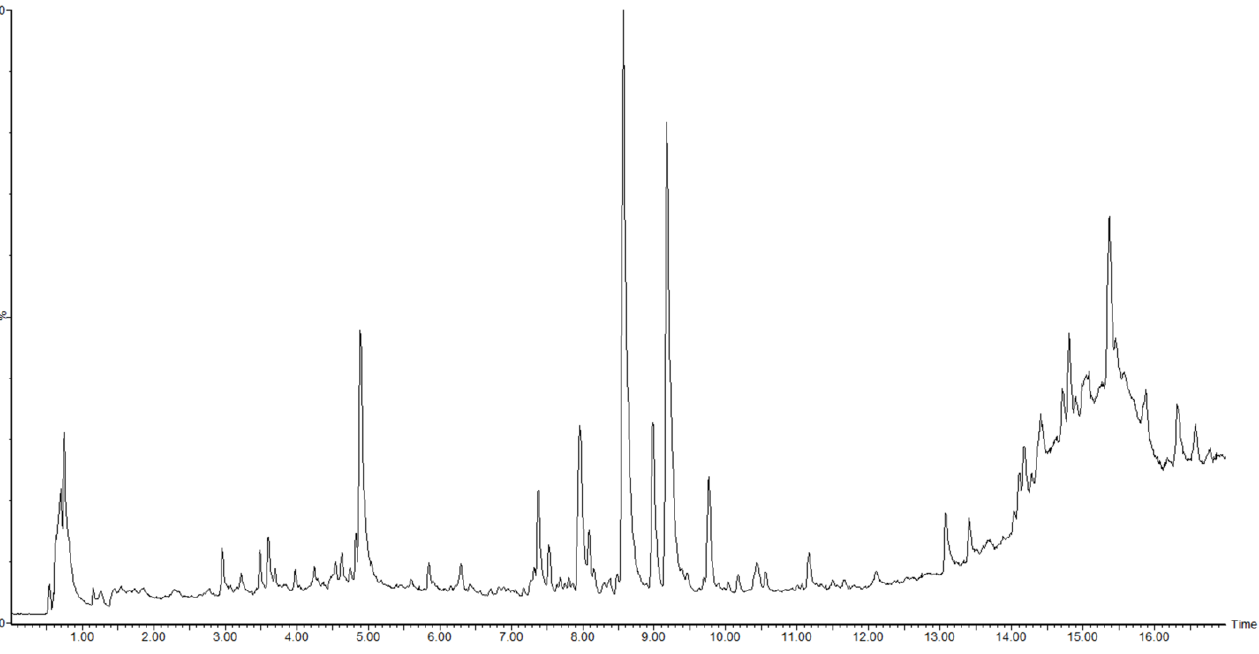
Figure 4. LC-MS total ion chromatogram of Qingpi 4 sample.